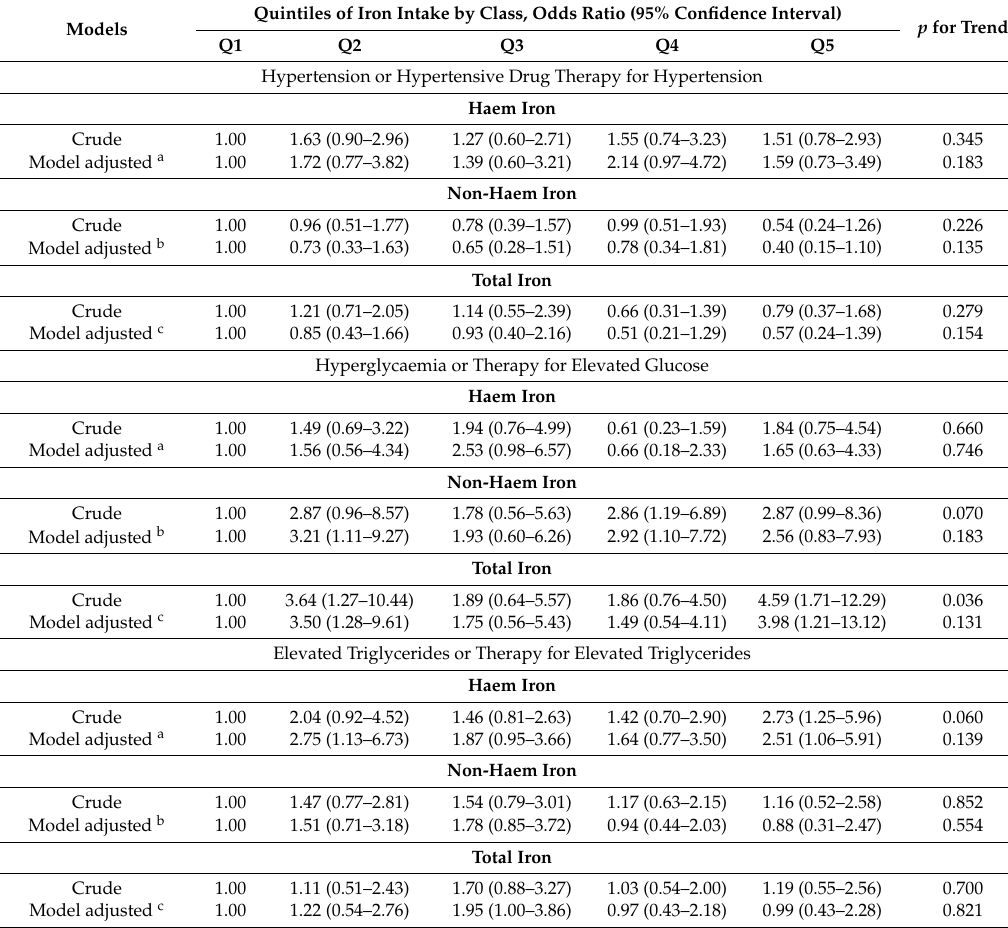
Table 2. Association between quintiles of iron intake (haem, non-haem and total) and components of metabolic syndrome in ISA-Capital. S ã o Paulo, Brazil,